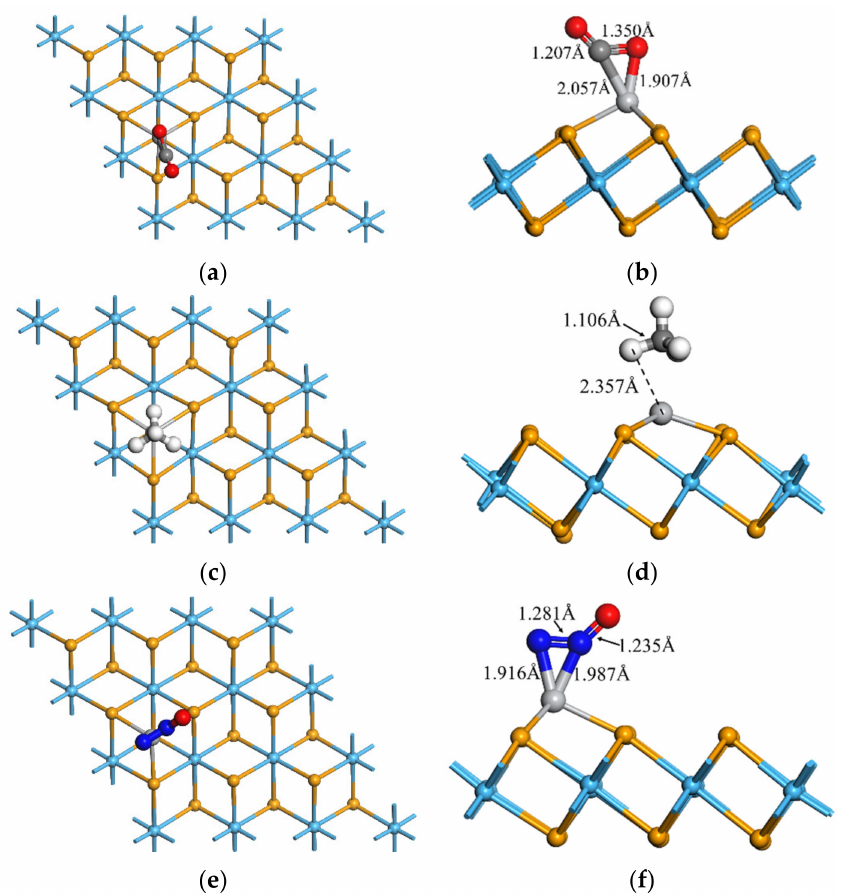
Figure 6. MSC of each adsorption system. ( a , b ) CO 2 adsorption system; ( c , d ) CH 4 adsorption system; ( e , f ) N 2 O adsorption